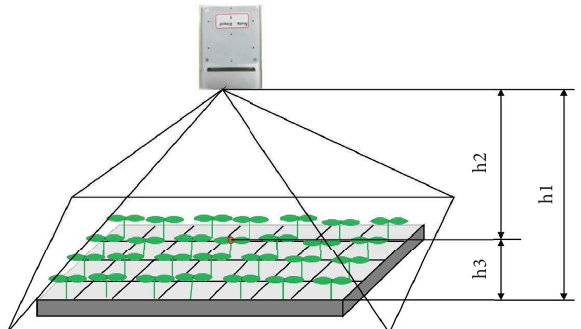
Figure 14: Schematic diagram of seedling height